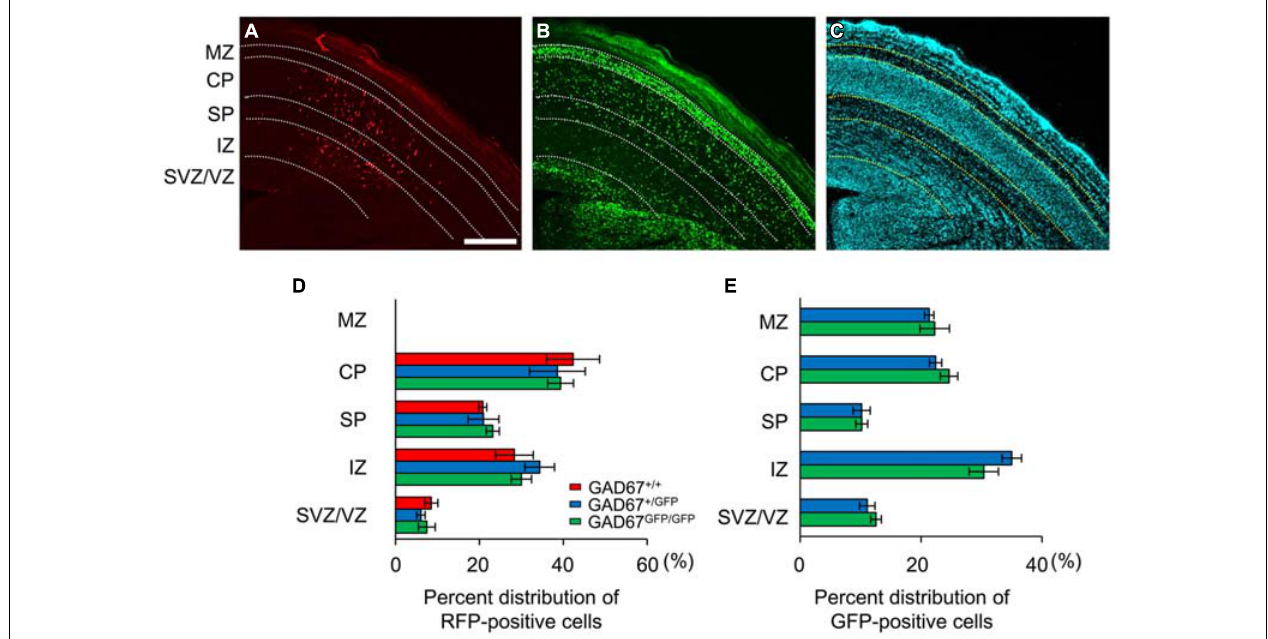
FIGURE 1 | Distribution patterns of radially migrating neurons and tangentially migrating GABAergic neurons in the cerebral cortex at E17.5. (A) Distribution of radially migrating neurons expressing mRFP ( red ) in a coronal section of the neocortex of a GAD67 + / GFP fetus. (B) Distribution of GABAergic neurons expressing GFP ( green ) in the same section. (C) The section was counterstained with DAPI.The dotted lines in (A–C) indicate the boundaries of the proliferative and migratory zones.The scale bar represents